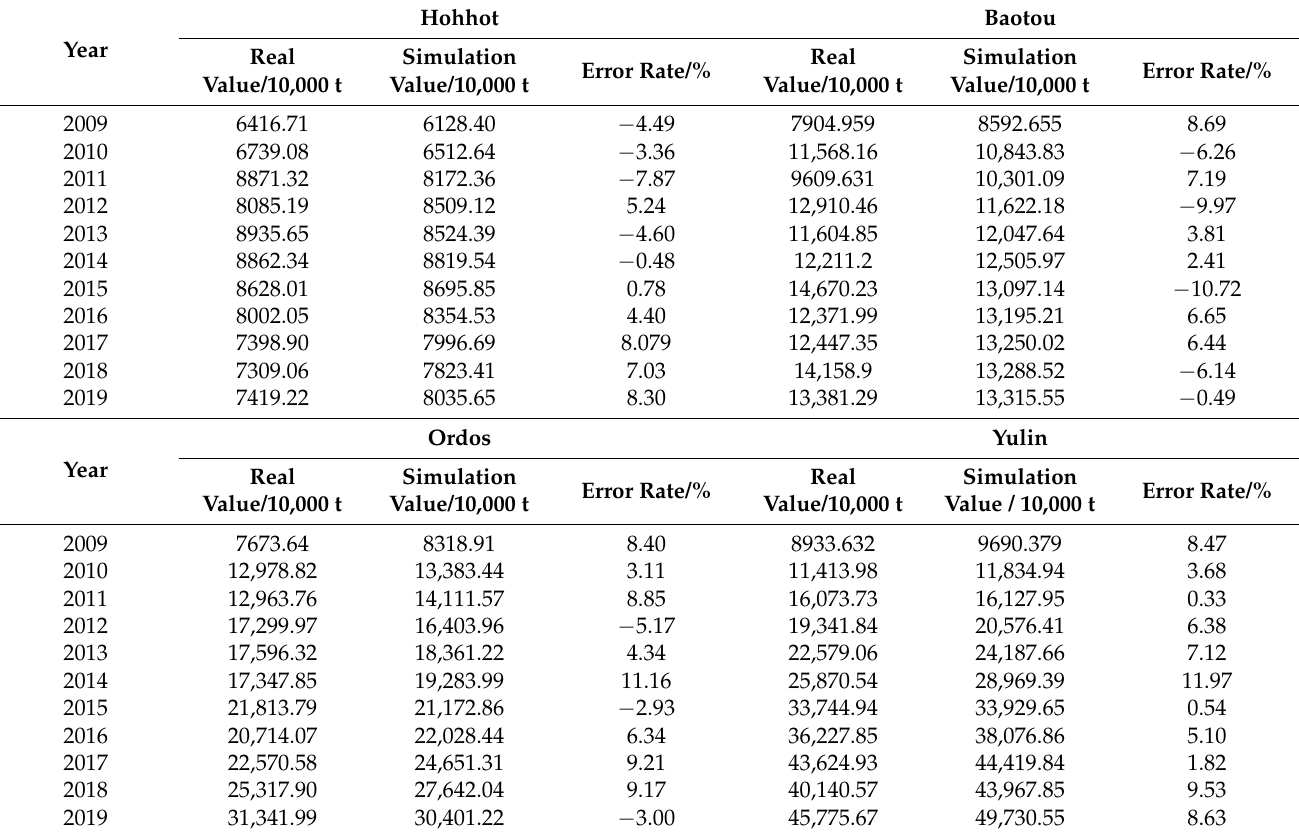
Table 5. Model validity test